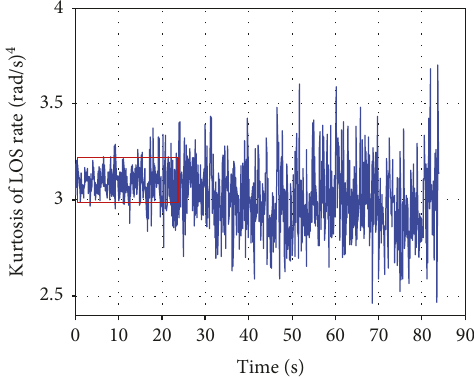
Figure 11: Kurtosis of the LOS rate (10 times of initial position error).